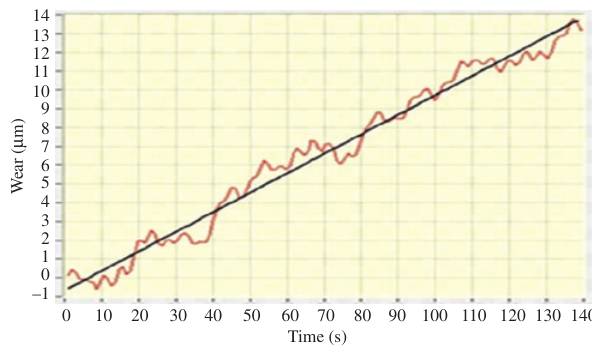
Figure 5: Graph generated at the time of the wear test on the pin-on-disc machine for wear.